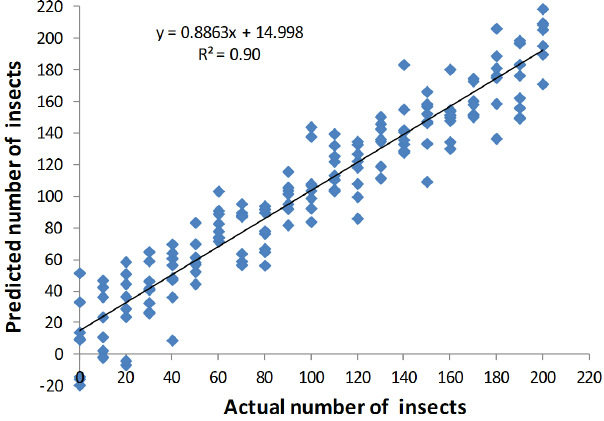
Fig. 6. Scatter plot of actual and predicted population of rice weevils in brown Hommali rice samples.